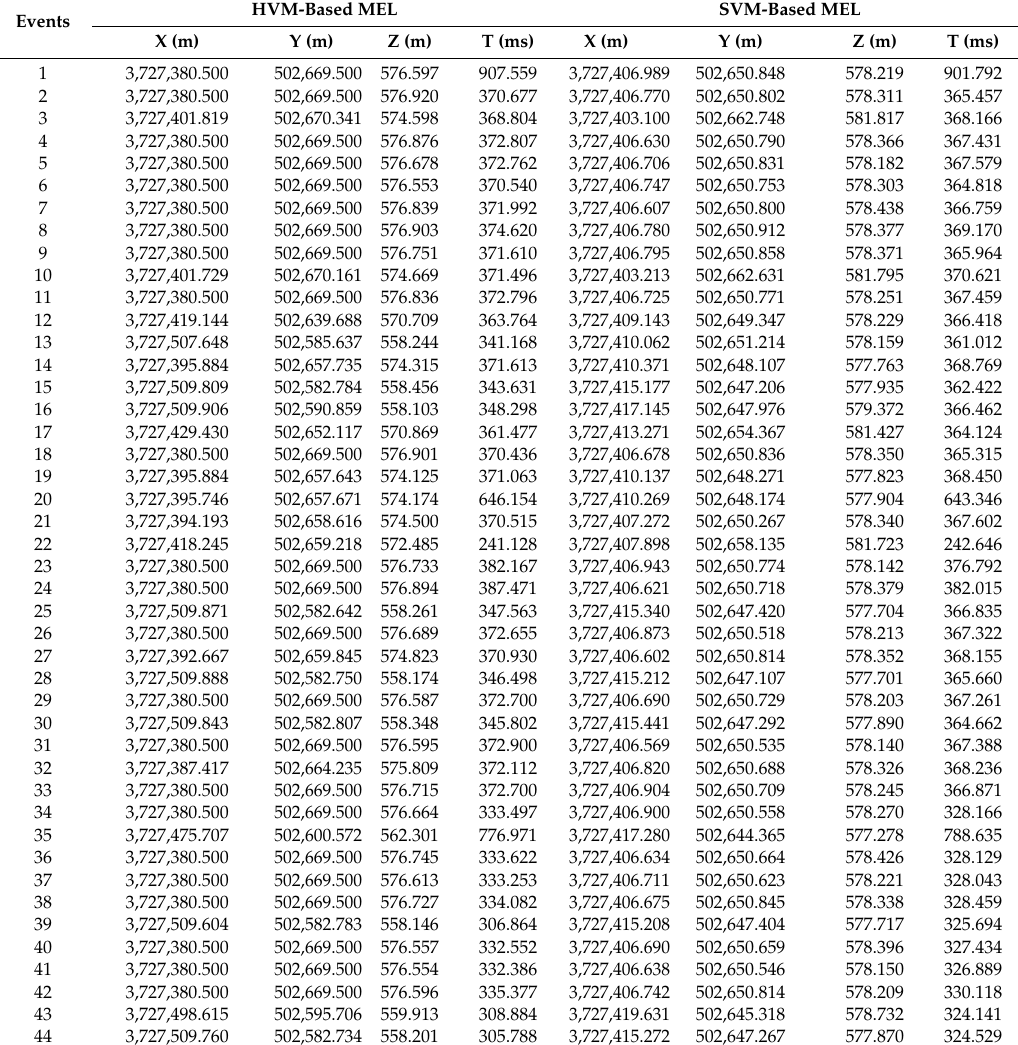
Table A2. Location Results Based on the HVM and SVM for the 44 Microseismic